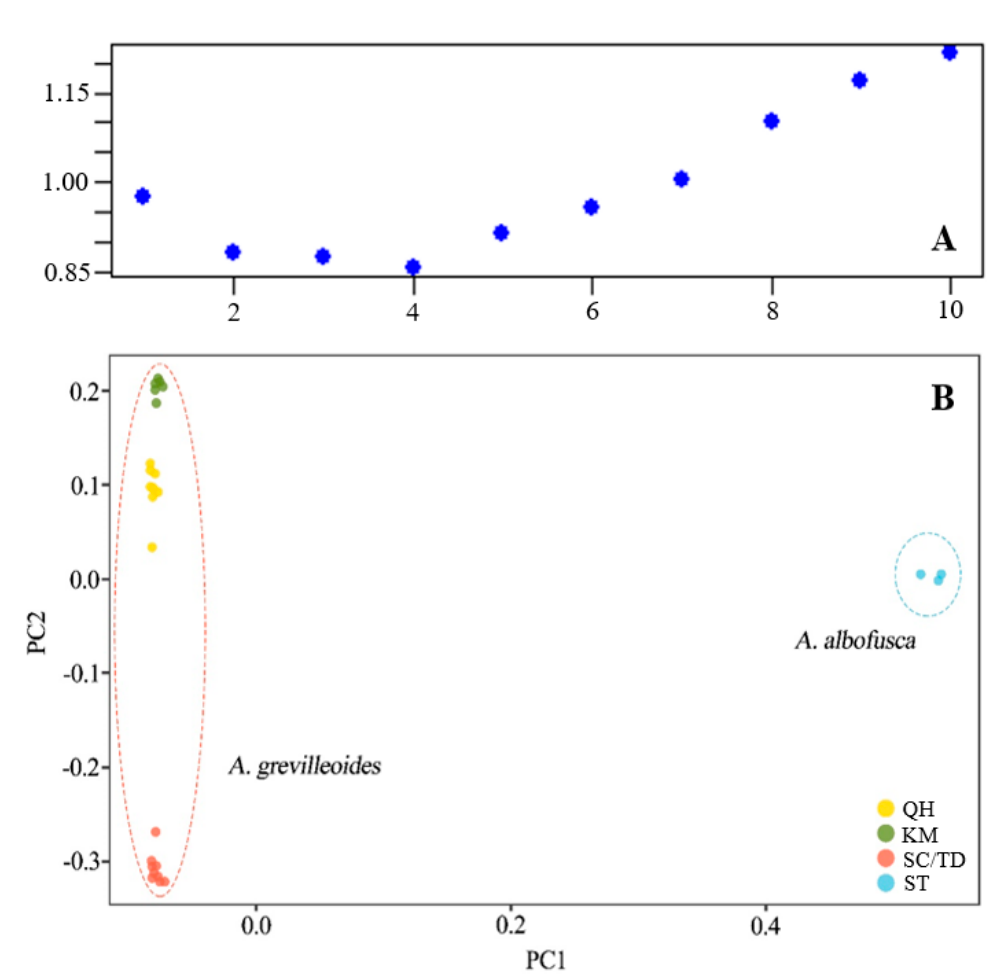
Figure 1. Analysis of Population Structure. Note: Aleuritopteris grevilleoides include QH (yellow), KM (green), SC (red), and TD (red); A. albofusca is ST (blue).